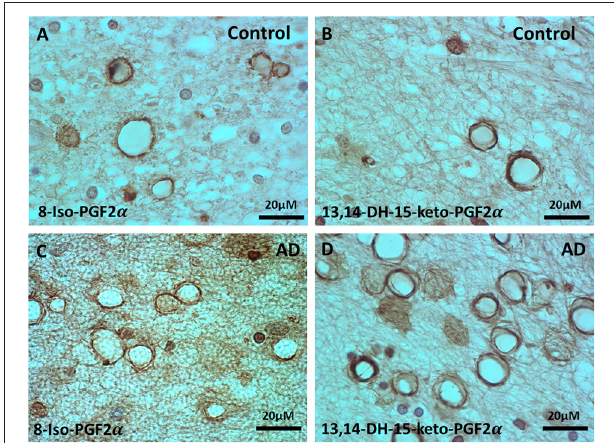
FIGURE 2 | Immunohistochemistry of oxidative markers, 8-Iso-PGF2 α and PGFM, in the vesicles of control and AD brains. (A) 8-Iso-PGF2 α stained vesicles of PVWM in control brain. (B) PGFM, also known as 13,14,-Dihydro-15-keto-PGF2 α , stained vesicles in the PVWM of the control brain. (C) 8-Iso-PGF2 α stained vesicles in AD PVWM. (D) PGFM stained vesicles in AD PVWM. Note: PGFM, Prostaglandin F2 α metabolite; 8-Iso-PGF2 α , 8-Iso-Prostaglandin F2 α ; PVWM, periventricular white matter; AD, Alzheimer’s disease; Bar = 20 µ m.